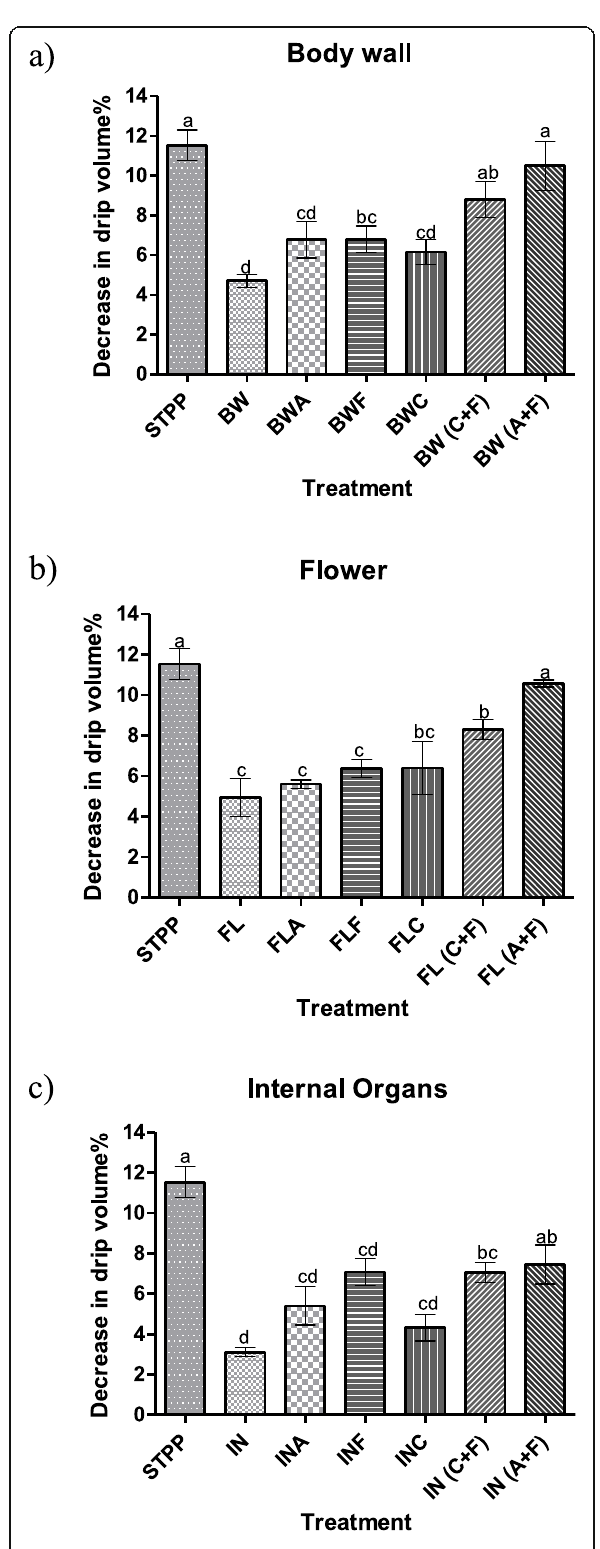
Fig. 11 Decrease in drip volume of sea cucumber C. frondosa protein hydrolysates a BW, Body wall; b FL, Flower; and c IN, Internal organs; A, Alcalase; F, Flavourzyme; C, Corolase; C + F, Mixture of Corolase and Flavourzyme; and A + F, Mixture of Alcalase and Flavourzyme. Different letters for the same concentration of all hydrolysates indicates significant difference at p <